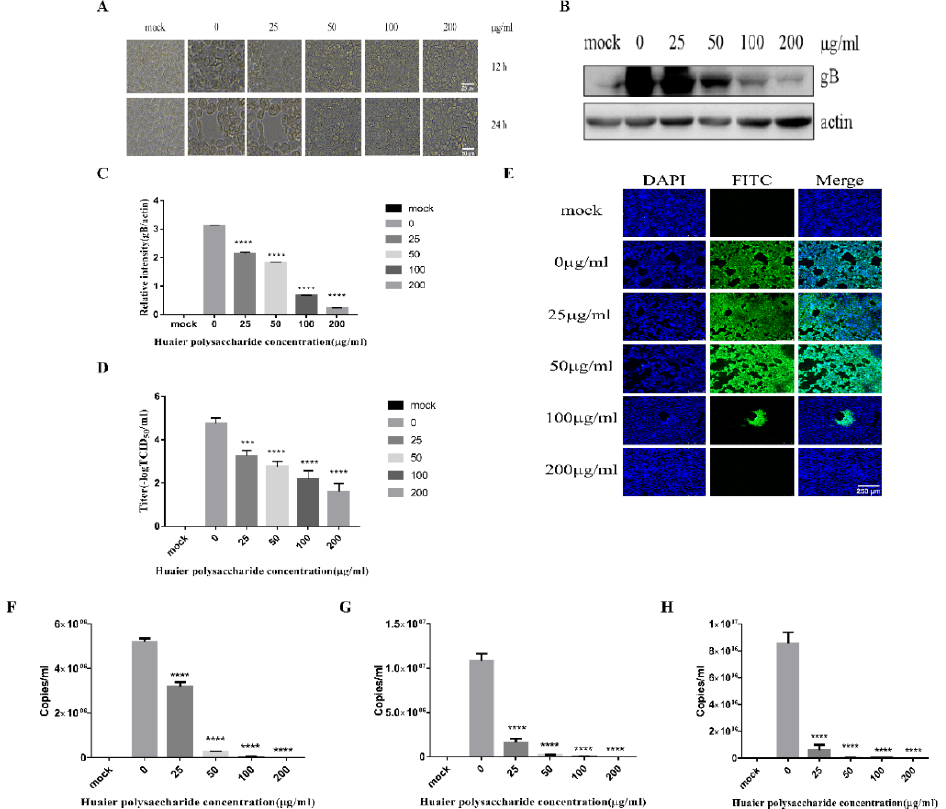
Figure 2. Huaier polysaccharide inhibits PRV XJ5 infection in PK15 cells. ( A ) Infected cells treated with 25, 50, 100, or 200 μg/mL Huaier polysaccharide for 12 or 24 h, showing changes in cell morphology. ( B ) gB and actin protein expression was determined through Western blot assay. ( C ) The relative intensity of intracellular gB to that of actin. Data are presented as means from three inde- pendent statistical experiments. The relative intensities of protein were quantified using Image J. Significance was analyzed using a one-tailed Student’s t -test. ( D ) The viral titers were evaluated through 50% tissue culture infective dose (TCID 50 ), and ( E ) immunofluorescent assay (IFA) for in- ternalized virus was performed. ( F – H ) PRV gB were assessed with qRT-PCR analysis in PK15 cells treated with Huaier polysaccharide (25, 50, 100, and 200 μg/mL) at 24 h.p.i. *** p = 0.0003, **** p < 0.0001. Data are shown as mean ± SD based on three independent experiments .